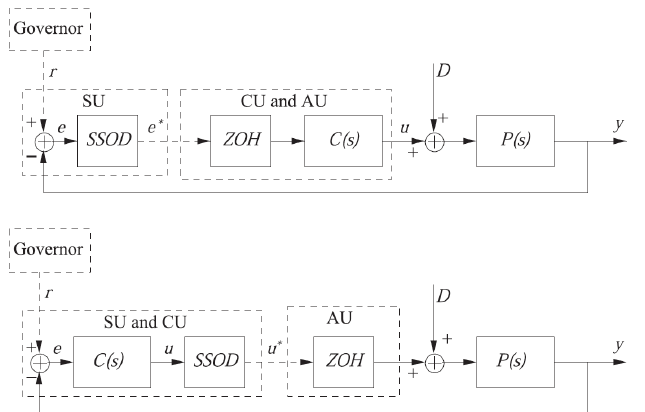
Figure 2. Symmetric-Send-On-Delta (SSOD) control architecture schemes: Symmetric-Send-On-Delta- Proportional-Integral (SSOD-PI) controller (top) and Proportional-Integral-Symmetric-Send-On-Delta (PI-SSOD) controller (bottom). Dashed blocks: Governor, Sensor Unit (SU), Control Unit (CU) and Actuator Unit